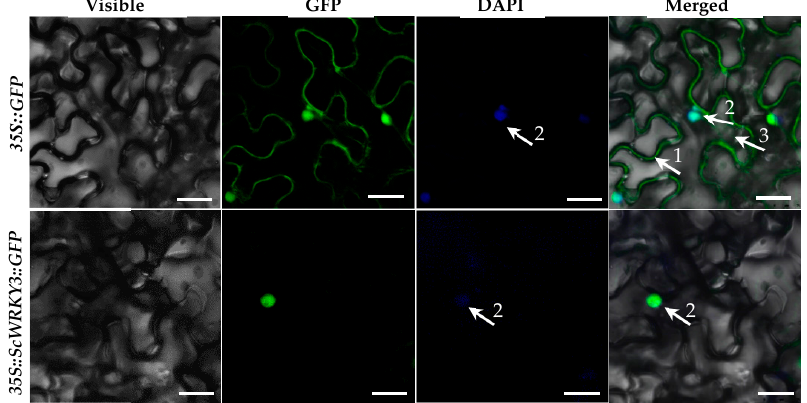
Figure 4. Subcellular localizations of 35S::GFP and 35S::ScWRKY3::GFP in Nicotiana benthamiana leaves. The epidermal cells of N. benthamiana are used for capturing images of visible light, green fluorescence, blue fluorescence, and visible light merged with green and blue fluorescence. White arrows 1, 2, and 3 indicate plasma membrane, nucleus, and cytoplasm, respectively. Scale bar = 50